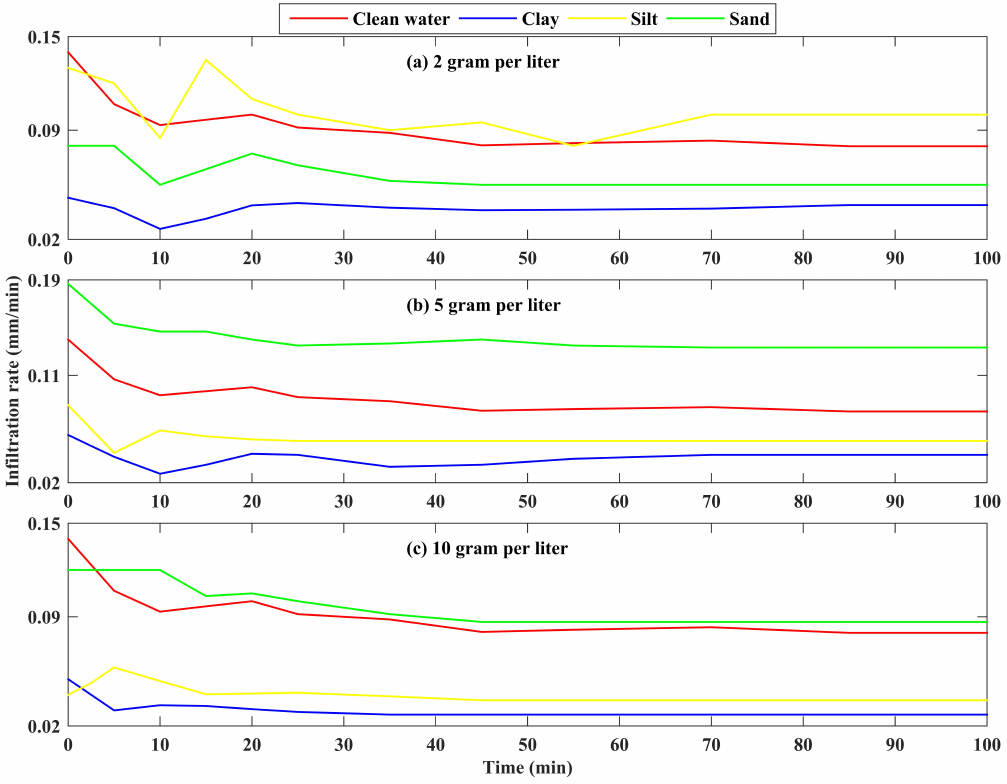
Figure 3. Comparison of infiltration rate under each of suspended solids categories (clay, silt and sand) and concentration level (0, 2, 5 and 10